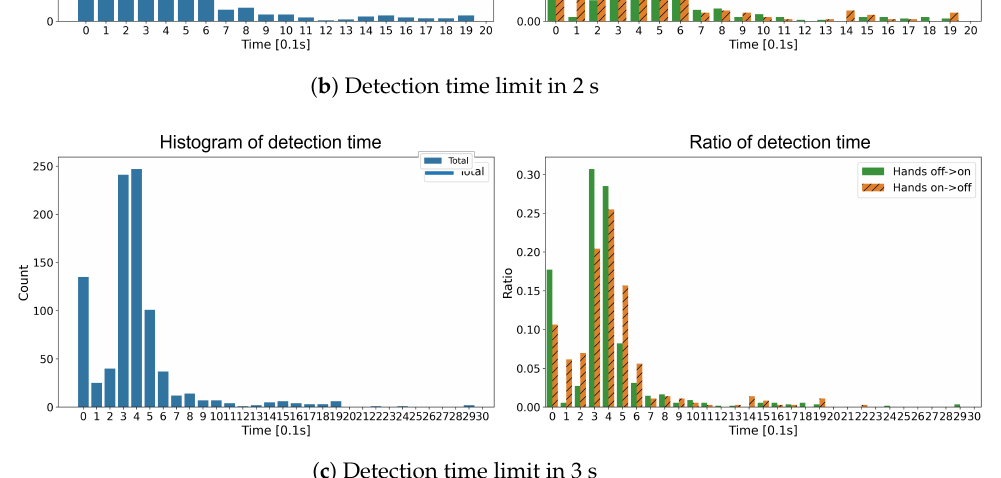
Figure 10. Detection time histogram according to the detection time limit. Ratio of detection time was represented on the right